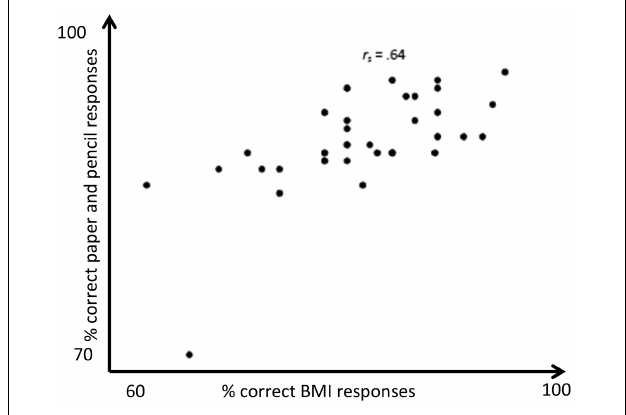
FIGURE 2 | Congruency of ECAS paper and pencil version and BMI version in healthy